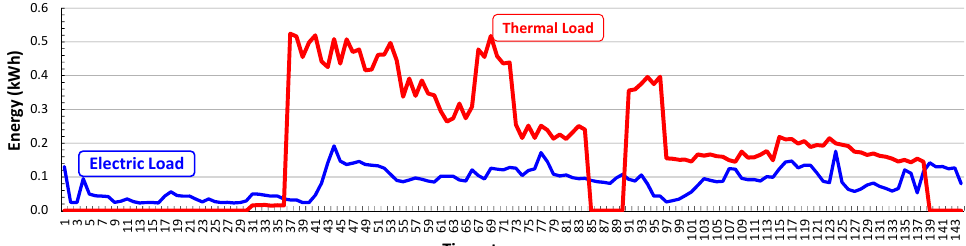
Figure 3. Electric and thermal loads for a residential flat in Northern Italy defined with a time step of 10 min over a typical winter day.